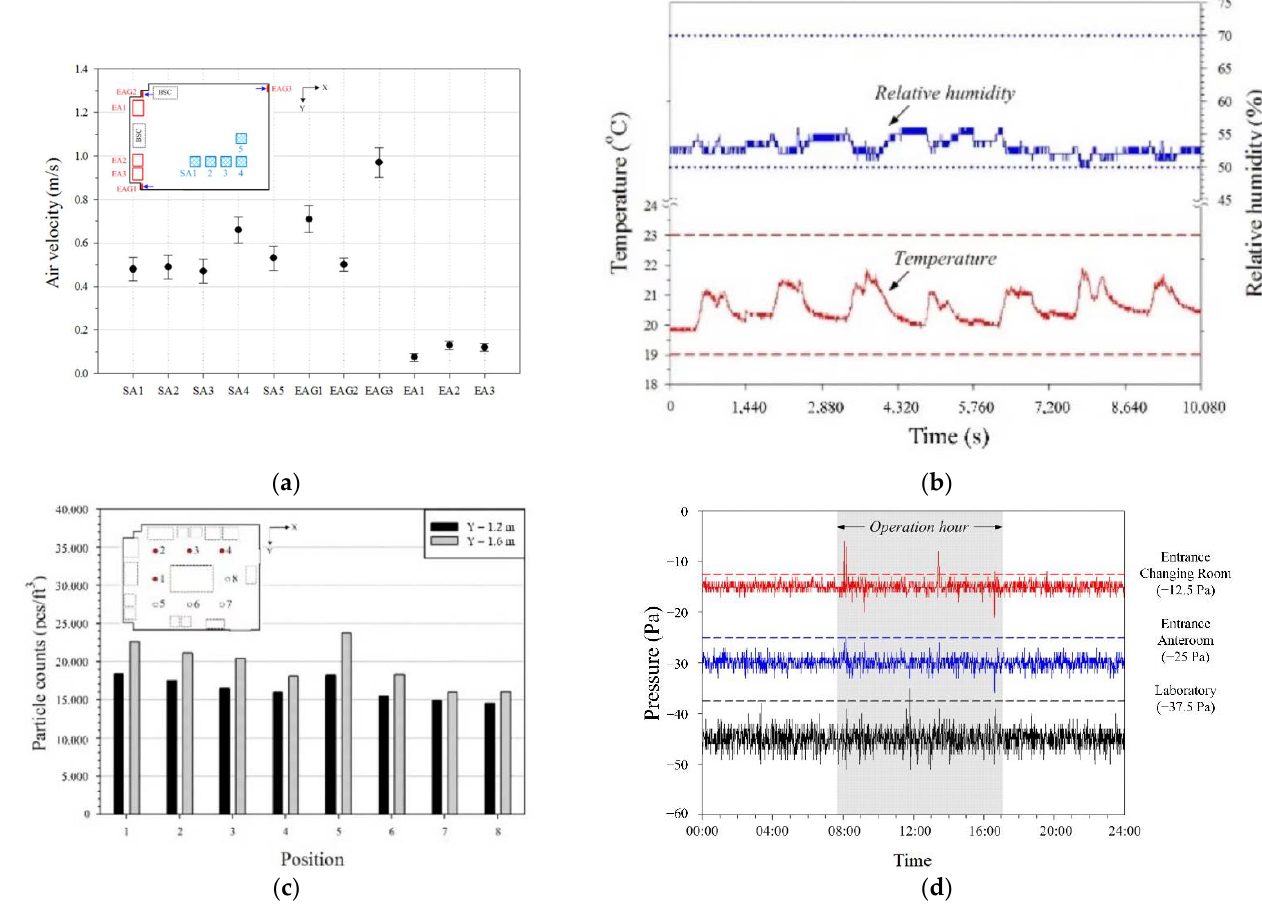
Figure 6. Field measurement results: ( a ) air velocity; ( b ) temperature and relative humidity; ( c ) particle counts; ( d ) pressure difference.